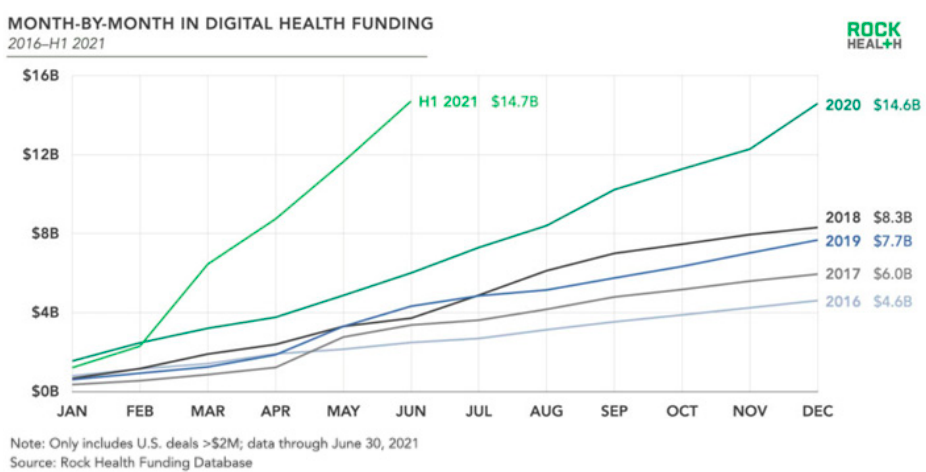
Figure 5. Investments in digitalisation of the health sector in 2016–2017 in the USA [29].